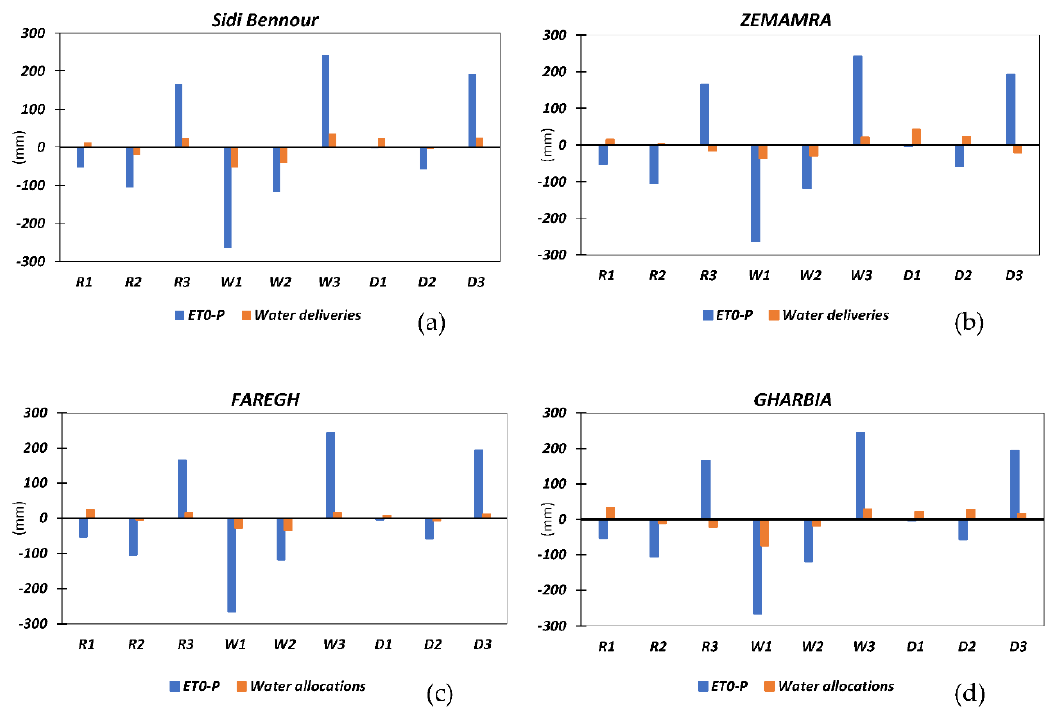
Figure 6. Doukkala irrigation scheme: Quarterly anomalies of ET 0 -P and W d for each district: ( a ) Sidi bennour, ( b ) Zemamra, ( c ) Faregh and ( d ) Gharbia; R: Reference year 2013–2014; W: Wet year 2014–